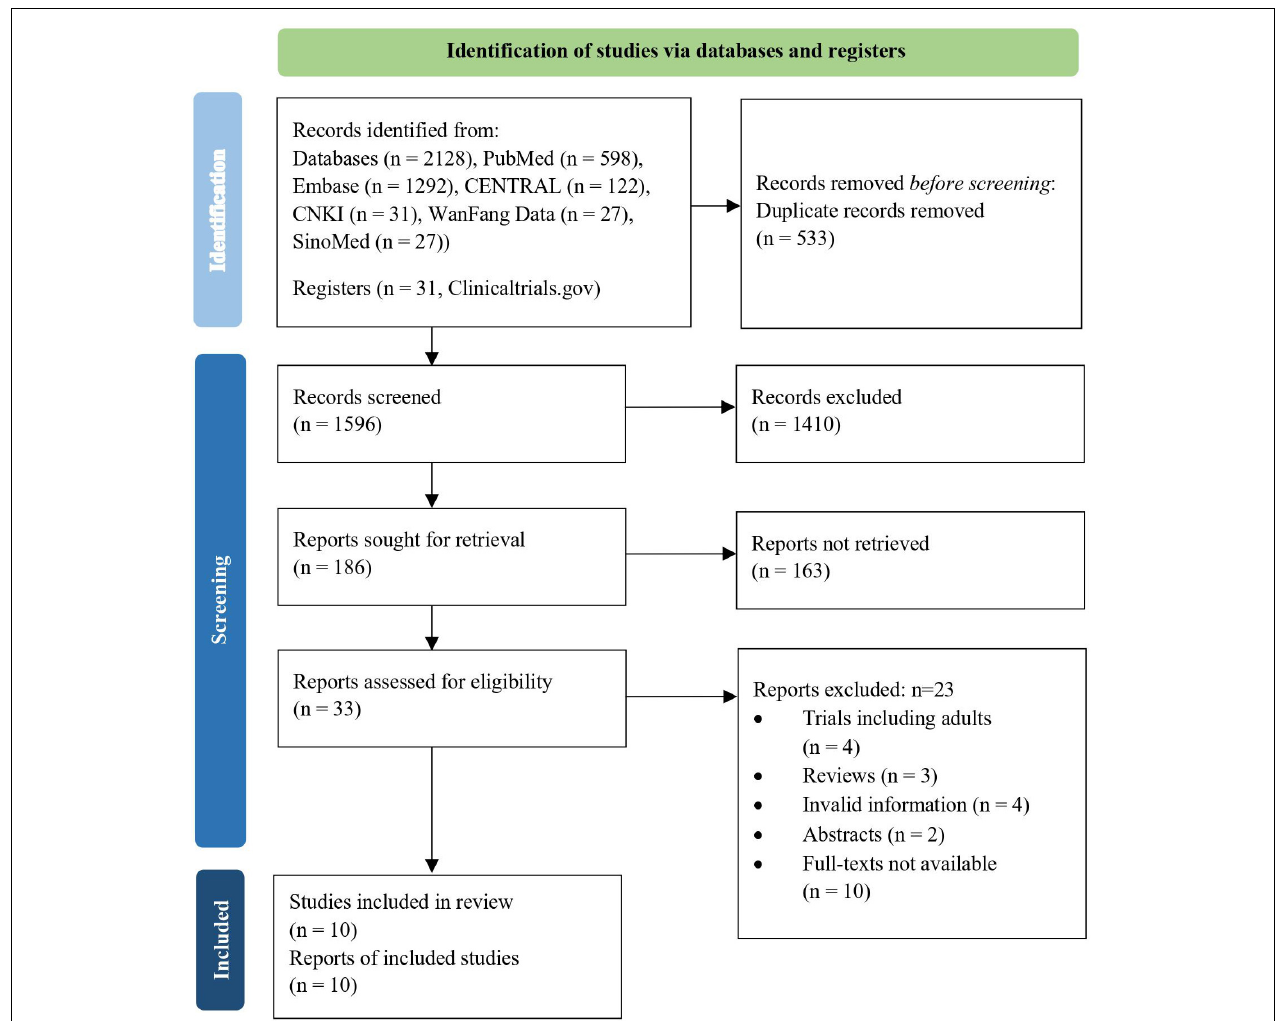
FIGURE 1 | Flow diagram of study selection